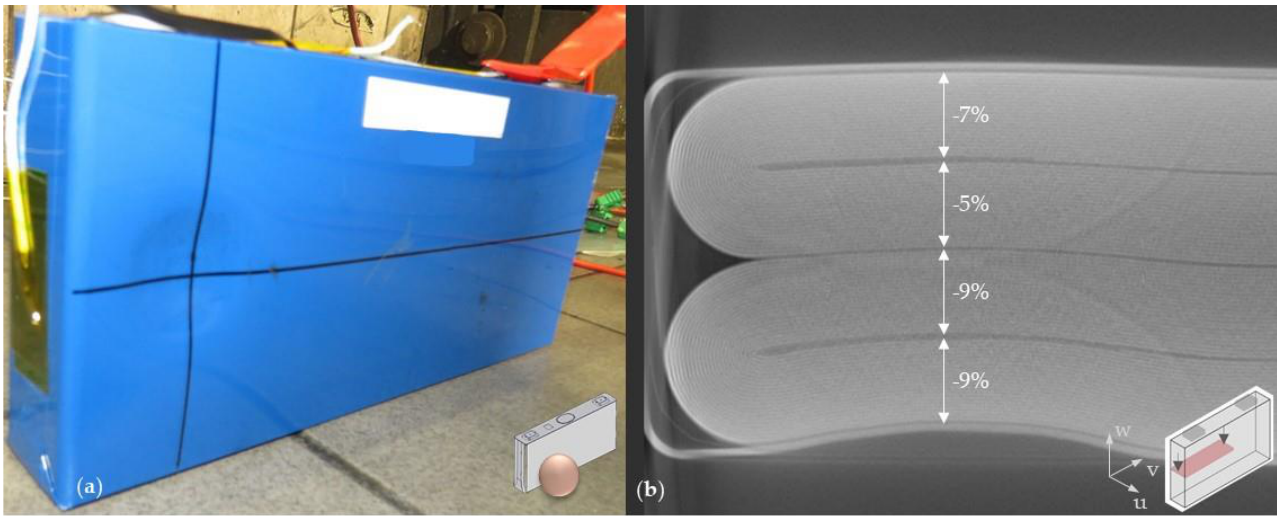
Figure 11. U-direction with hemispherical impactor: ( a ) deformed cell; ( b ) CT-Scan at uv-plane.